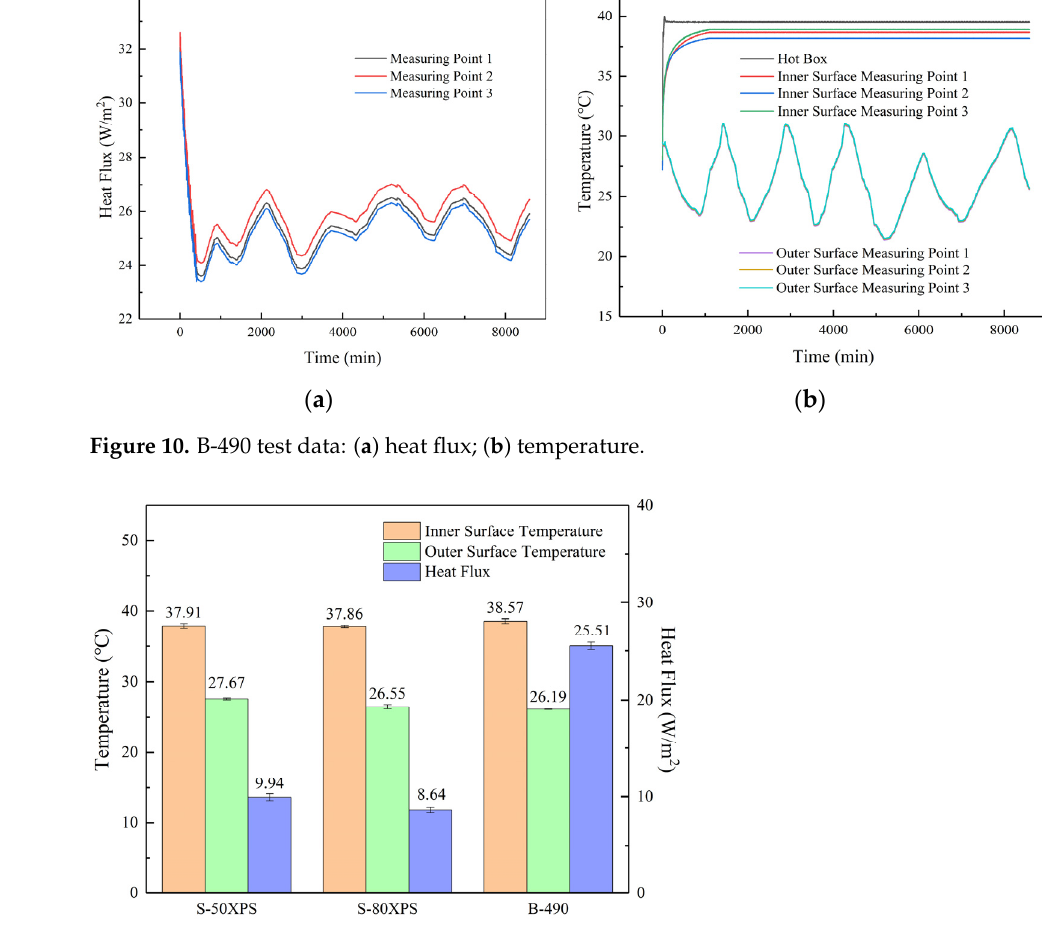
Figure 10. B-490 test data: ( a ) heat flux; ( b ) temperature.